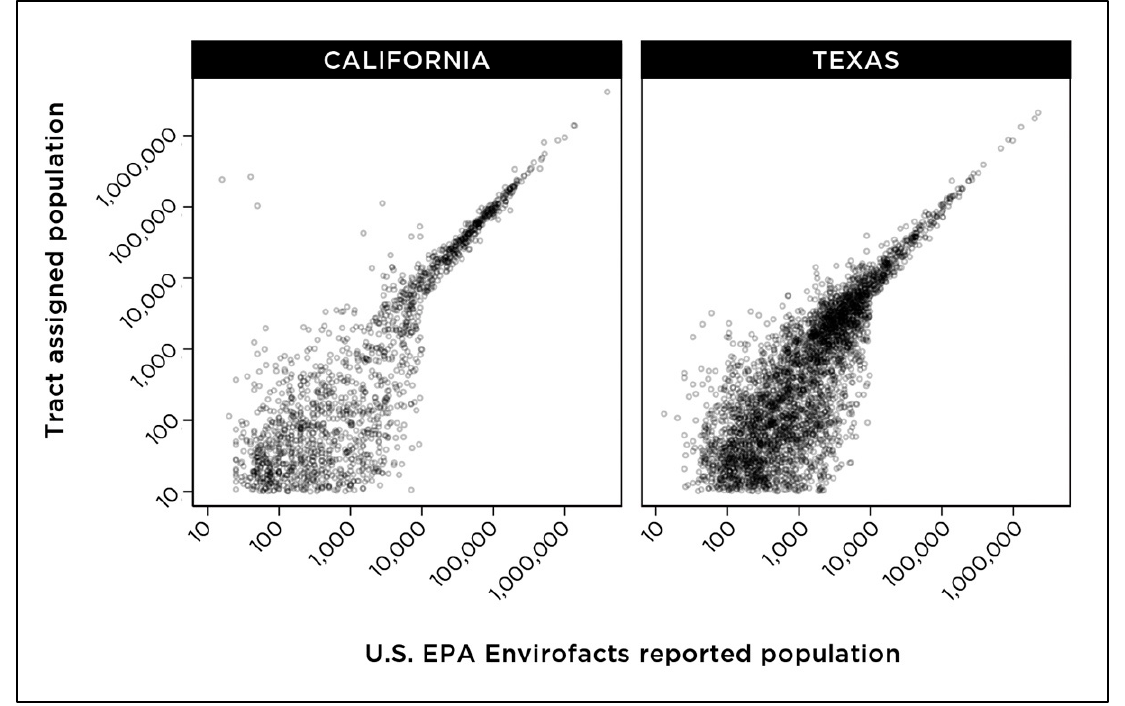
Figure 4. Population estimates calculated using census tract assignment compared with reported population statistics from the U.S. EPA Envirofacts database.